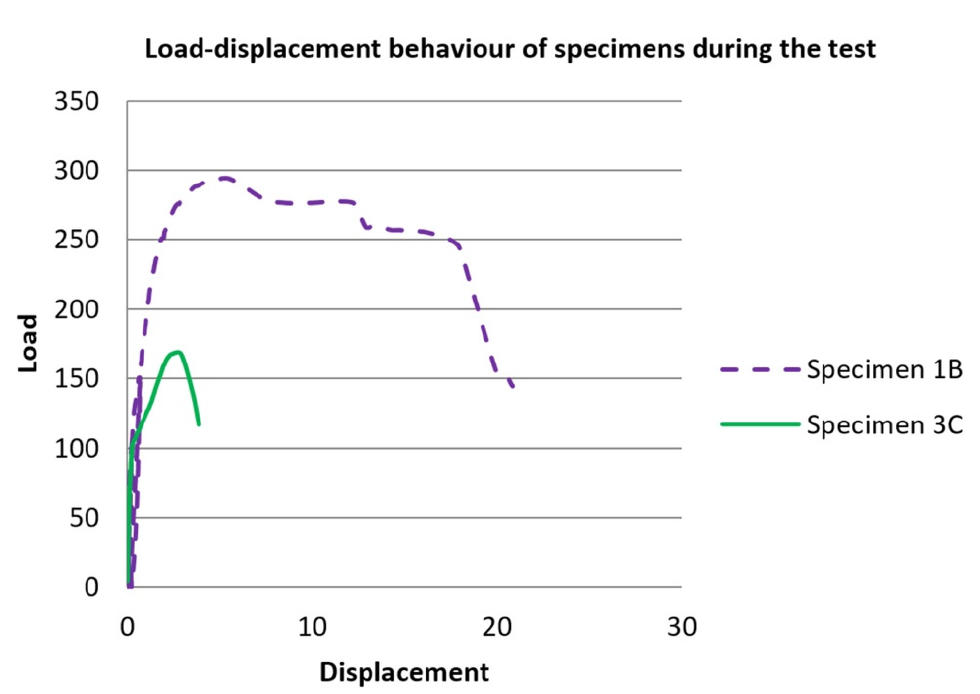
Figure 6. Load-displacement curves—specimens 1B and 3C.